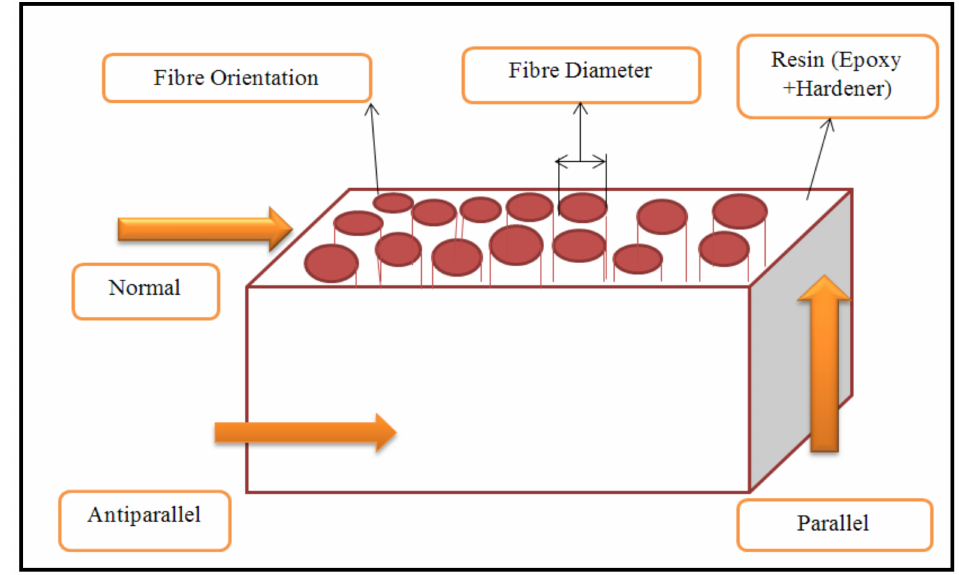
Figure 2. Schematic showing the orientation of fibres with respect to sliding